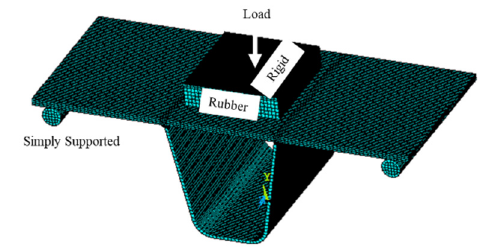
Figure 4. Finite simulation model.